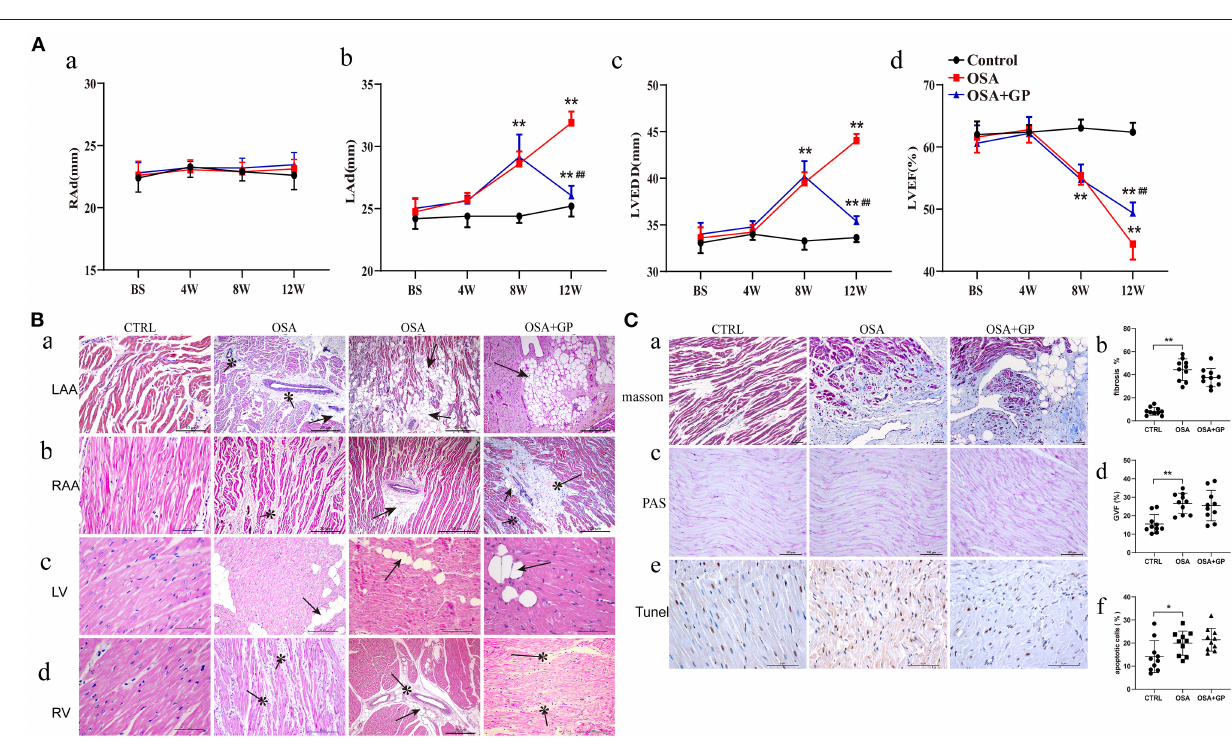
FIGURE 6 | Effects of SLGP ablation on structural remodeling. (A) Changes of echocardiographic parameters among the three groups; (B) HE staining of typical myocardial histopathological changes. (C) Myocardial histopathological changes in LA were observed with different staining (a–c): quantitative analysis of Masson staining (b), PAS staining (d), and TUNEL staining (f) among the three groups. * P < 0.05 vs. CTRL, ** P < 0.01 vs. CTRL, ## P < 0.01 vs. OSA. RAd, right atrial end-diastolic diameter; LAd, left atrial end-diastolic diameter; LVEDD, left ventricular end-diastolic diameter; LVEF, left ventricular ejection fraction. RAA, right atrial appendage; LV, left ventricular; RV, right ventricular; TUNEL, terminal deoxynucleotidyl transferase dUTP nick end labeling; PAS, periodic acid-Schiff; other abbreviations as in Figure 1